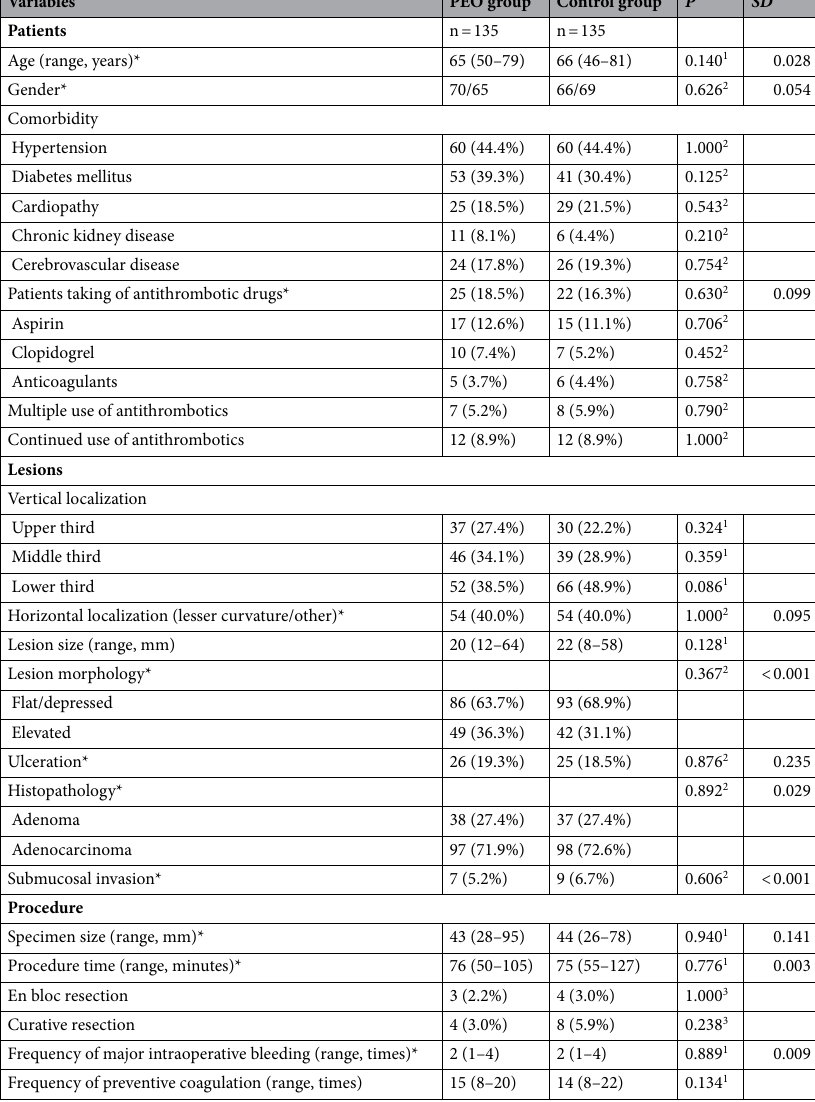
Table 2. Baseline characteristics of patients after propensity score matching. *Variables included in propensity score matching as matching factors. 1 Mann–Whitney U test. 2 χ 2 test. 3 Fisher exact